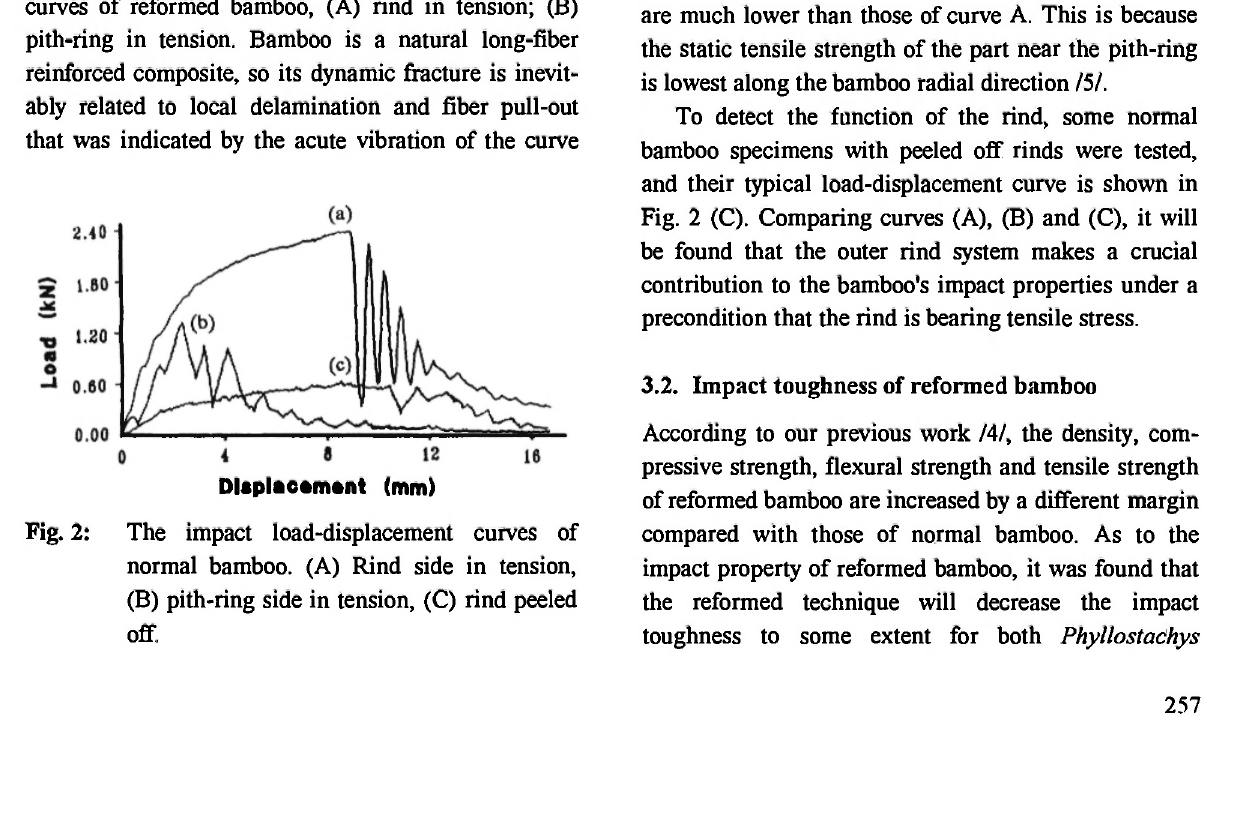
Fig. 1: The impact toughness of normal bamboo and reformed bamboo when their different sides are subjected to impact load.